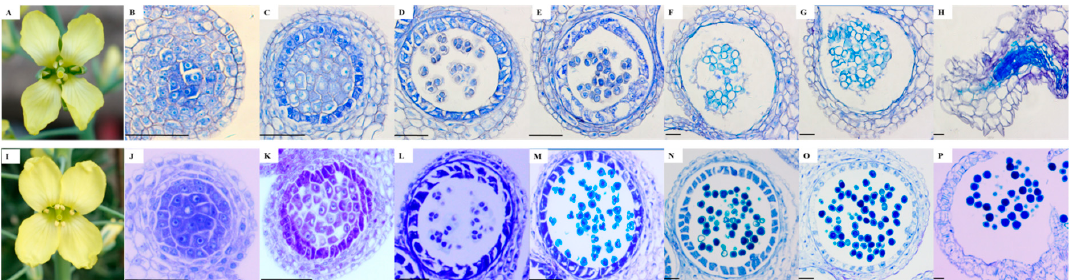
Figure 1. Phenotypes of Ogura cytoplasmic male sterility (Ogura-CMS) line CMS01-20 and its corresponding maintainer line F01-20. ( A – H ) CMS01-20; I-P: F01-20. ( A ) CMS01-20 shows degenerated anthers and no visible pollen; ( I ) F01-20 is fertility; ( B , J ) microsporocyte stage; ( C , K ) meiotic